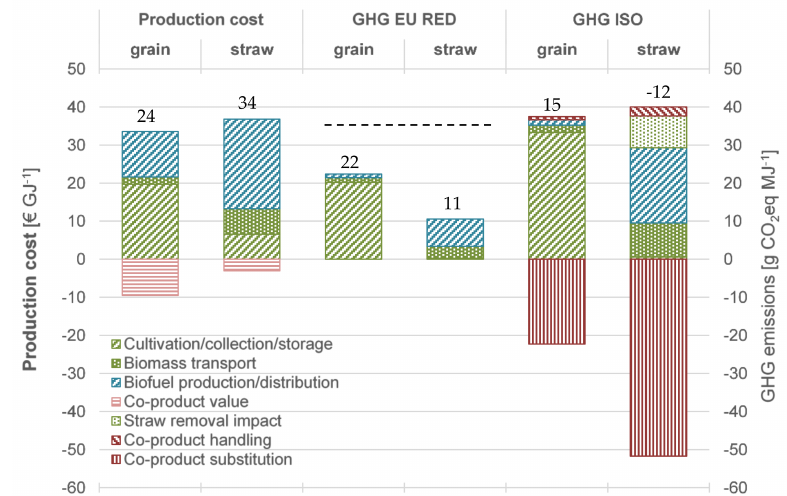
Figure 3. Production cost and emissions for ethanol produced in PR1 calculated according to the methods in the EU RED and the ISO standard. The dotted line indicates maximum GHG emissions for new installations according to the EU RED. Numbers above the columns indicate net value.